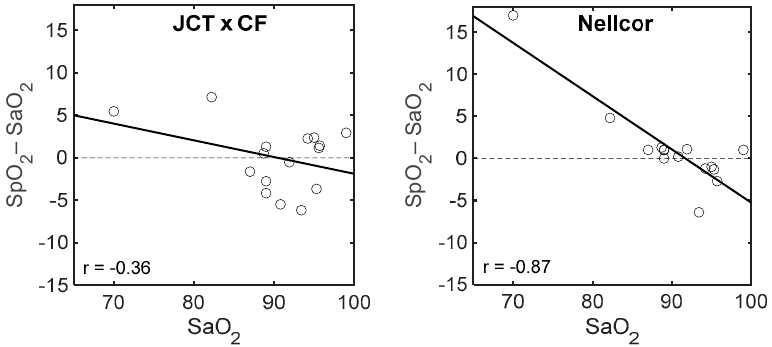
Figure 9. The regression lines of SpO 2 –SaO 2 vs. SaO 2 for Nellcor and JCT pulse oximeters for the neonate data.